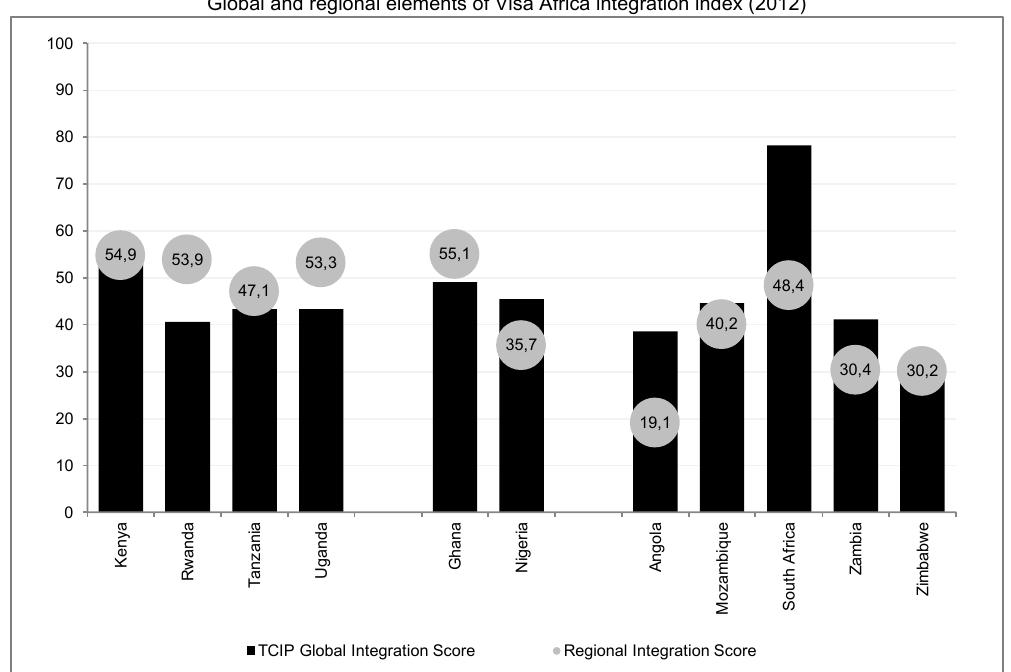
Global and regional elements of Visa Africa integration index